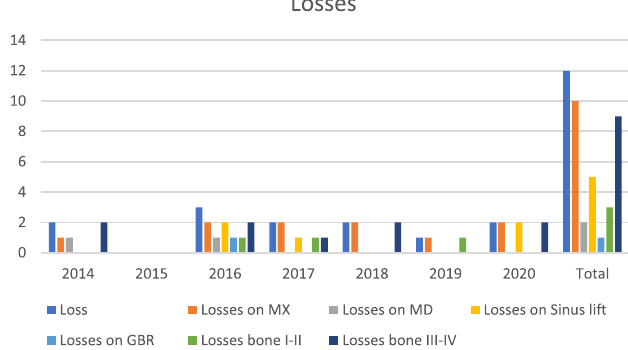
Fig. 1. Losses according to bone type, preimplant surgery and bone localization.